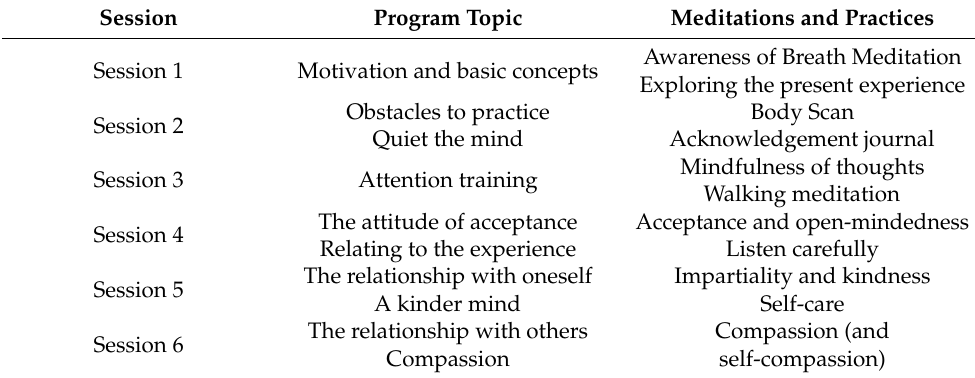
Exploring the present experience Body Scan